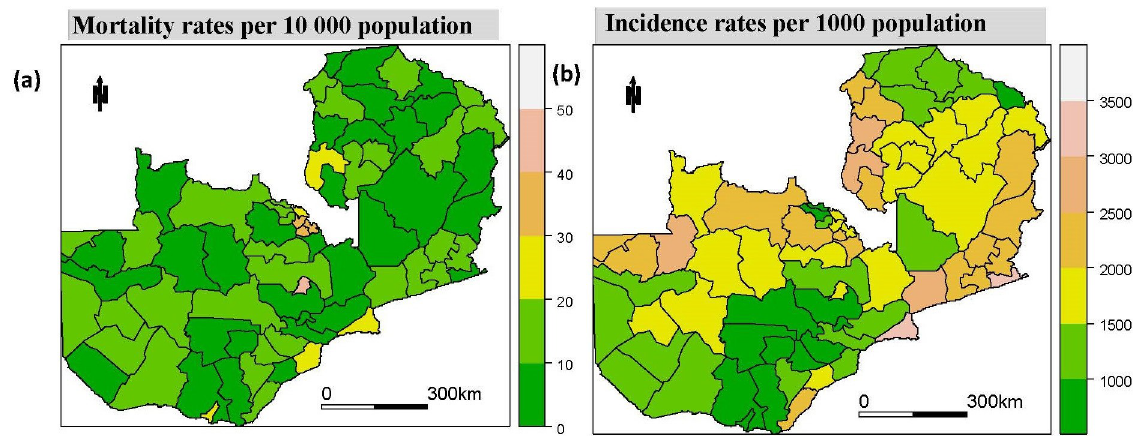
Fig 3. Spatial patterns of malaria mortality and incidence rates, 2000 to 2015. (A) and (B) show the mean spatial pattern of both mortality and incidence rates between the years 2000 and 2015.